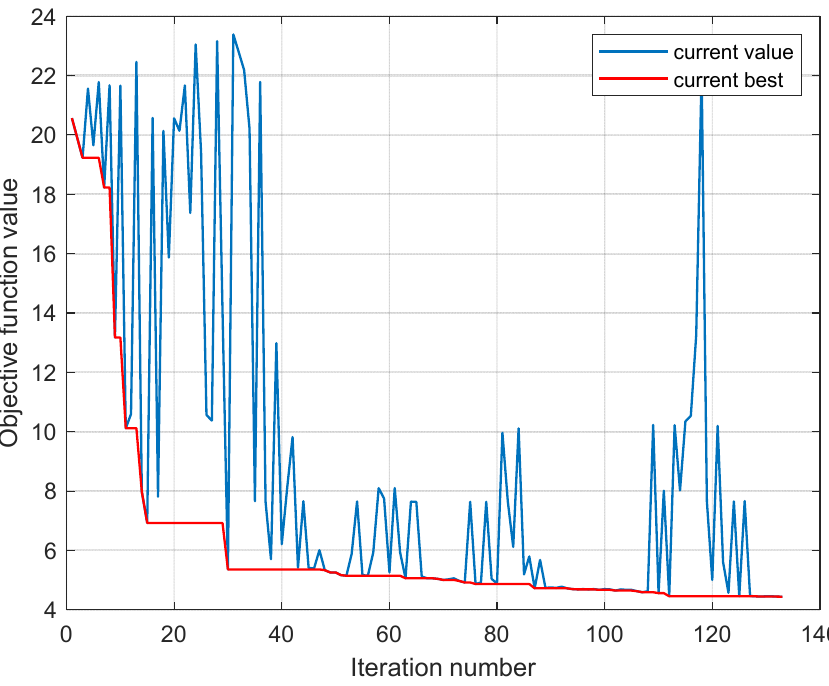
Figure 9. History of the optimization process.